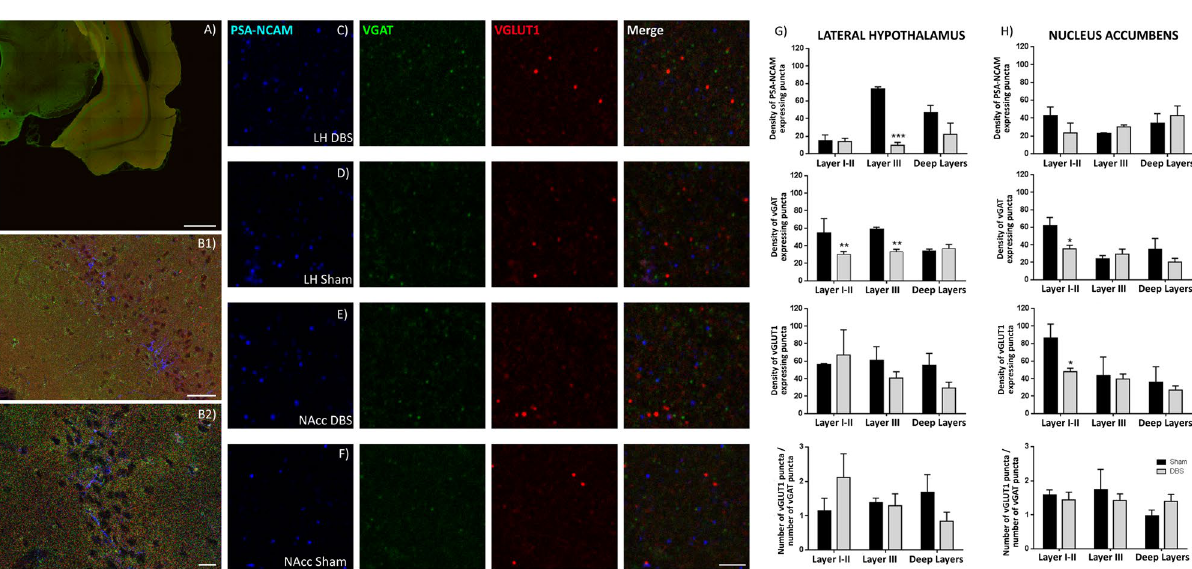
Figure 5. DBS effects on synaptic plasticity in the entorhinal cortex. ( A ) Panoramic view of the entorhinal cortex and ventral hippocampus immunostained for VGAT and VGLUT1. ( B1 ) Panoramic view of the lateral entorhinal cortex. ( B2 ) Detailed view of the layer III of the lateral entorhinal cortex. ( C , D ) Expression of molecules related to neuronal plasticity in layer III of LH stimulated animals ( C ) and in LH-sham animals ( D ). ( E , F ) Expression of molecules related to neuronal plasticity in layer III in NAcc-stimulated animals ( E ) and NAcc-sham animals ( F ). ( G , H ) Graphs showing the density of puncta (number of puncta/900 µm 2 ) expressing PSA-NCAM, VGAT, VGLUT1 and the E/I balance in the rats receiving stimulation in the LH ( G ) and the NAcc ( H ). Student’s T-test, p-values: * < 0.05, ** < 0.01, *** < 0.001. VGAT vesicular GABA transporter; VGLUT vesicular glutamate transporter 1. Scale bar 500 µm for ( A ), 50 µm for ( B1 ), 20 µm for ( B2 ), 3 µm for ( C – F